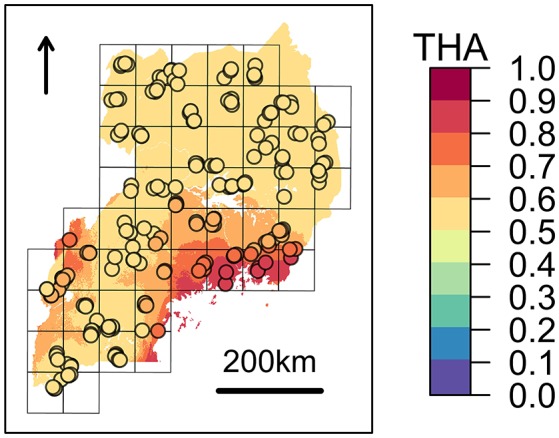
Expected zebuine proportion of the genomic region candidate for tick resistance. The association inferred through beta regression between Tharparkar ancestry (THA) and average Rhipicephalus appendiculatus occurrence probability per cell (Table 6) was used to generalize expected zebuine ancestry over Uganda. Colour key corresponds to predicted THA proportion, with increasing values from the blue to the red tones. Sampled farms are represented with circles, and coloured according to the predicted THA proportion at their geographical location.